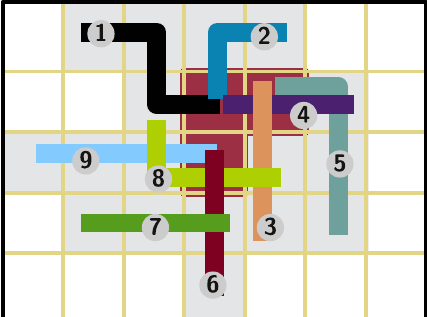
Figure 8. Schematic 2-D example of a case in which many ensem- ble members predict a WCB feature but spatial variation causes low probability values. Consider an ensemble of ten members, of which nine members predict a WCB feature (depicted by the differ- ent coloured and numbered lines). In the example, only a maximum of three features overlap in any grid cell (resulting in a maximum probability of 30%; red grid cells). By storing the indices of all members that contribute to a given grid cell, our method is able to determine the members that contribute to a probability region. In the example, eight members (that is, 80%) contribute to the red region. The grey grid cells illustrate the 10% region.